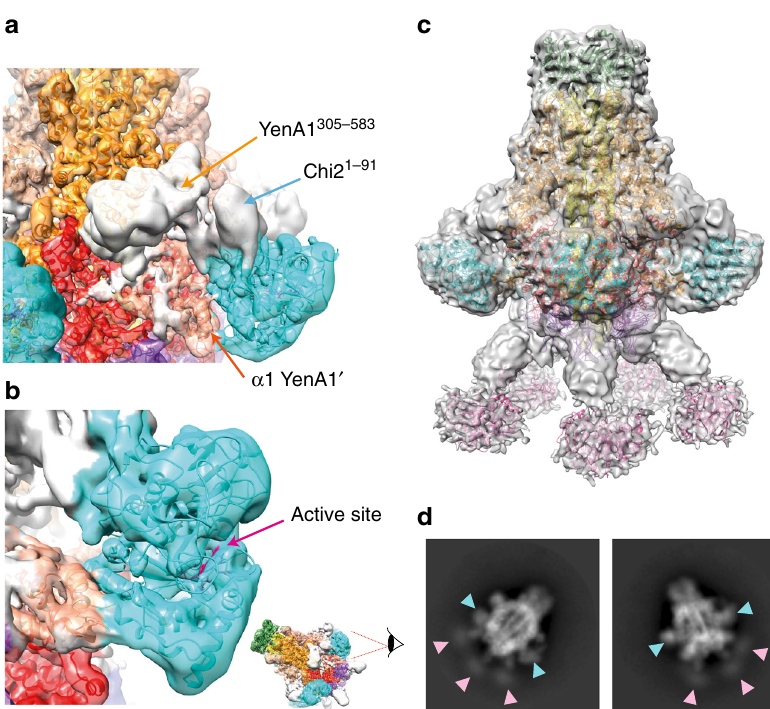
Fig. 2 Chitinases in the context of the pre-pore structure. a Two unmodelled subdomains form the major interacting surface between YenA1 and Chi2: an insertion into the YenA1 α -helical shell (YenA1 305 – 583 ) and the N-terminal domain of Chi2 (Chi2 1 – 91 ). A secondary interaction surface involves the α -helical shell ( α 1) from the neighbouring protomer (YenA1 ′ ). b The Chi2 active site (magenta) sits at the bottom of a downward facing substrate cleft. The Chi1 subunit could not be accommodated within any of the unbuilt regions of the fi nal, high resolution map (Fig. 1) but densities that corresponded in size to the Chi1 crystal structure (PDB ID 3oa5) were resolved in maps produced during earlier re fi nement iterations ( c ; X-ray structures coloured in pink and fi tted as a rigid body) and were also clearly evident in reference-free class averages ( d ; pink